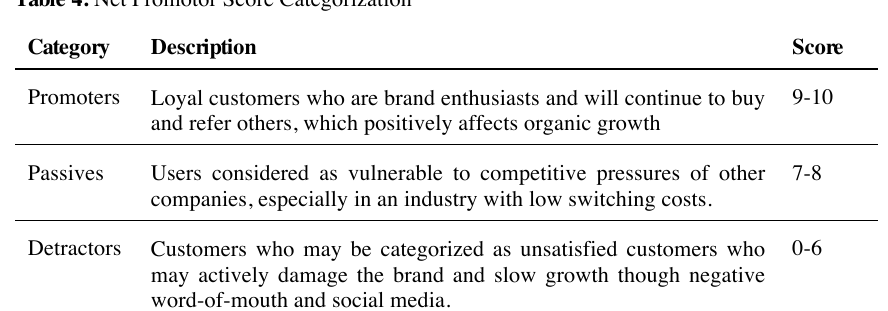
Table 4. Net Promotor Score